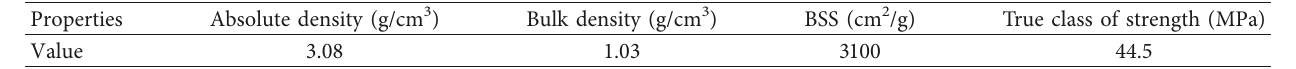
Table 4: Physical and mechanical properties of cement.